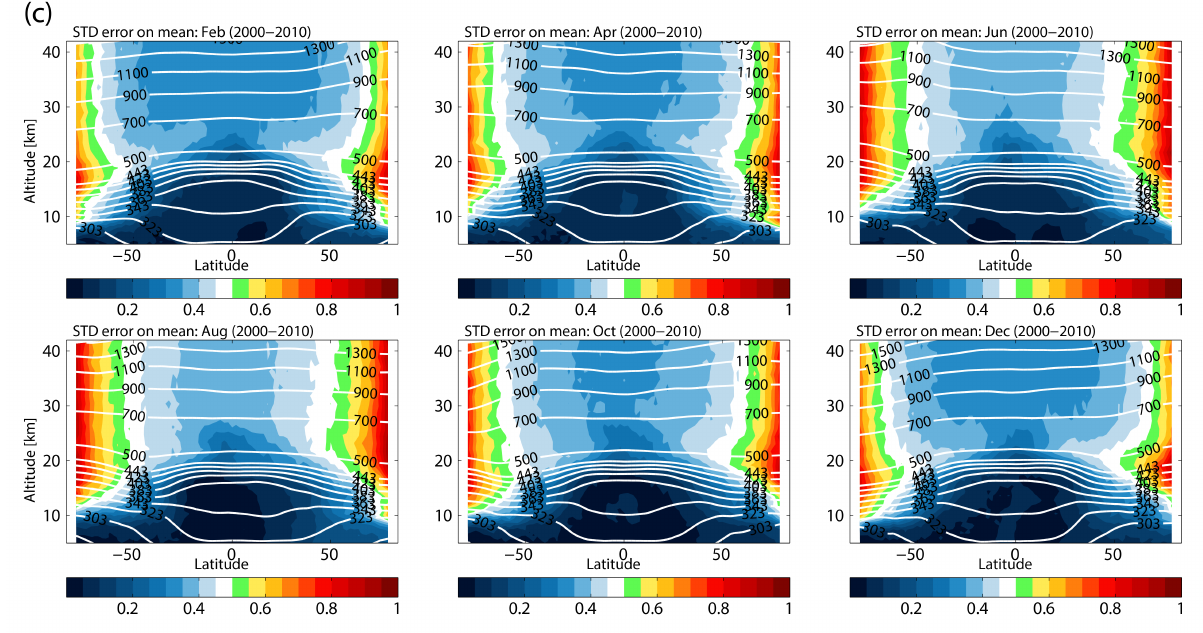
Figure 6. (a) Global distribution of the seasonal cycle of the reconstructed monthly mean CO 2 (in ppmv) in the upper troposphere and the lower stratosphere from 5 to 25km for the odd months of 2010. (b) Same as (a) but for the even months of 2010 and the altitude range from 5 to 45km. CO 2 calculated on model levels is first interpolated to altitude levels using the latitude dependency of the zonally and monthly averaged geopotential. (c) The standard error of the mean CO 2 over the 2000–2010 period. The white contours show the isentropic